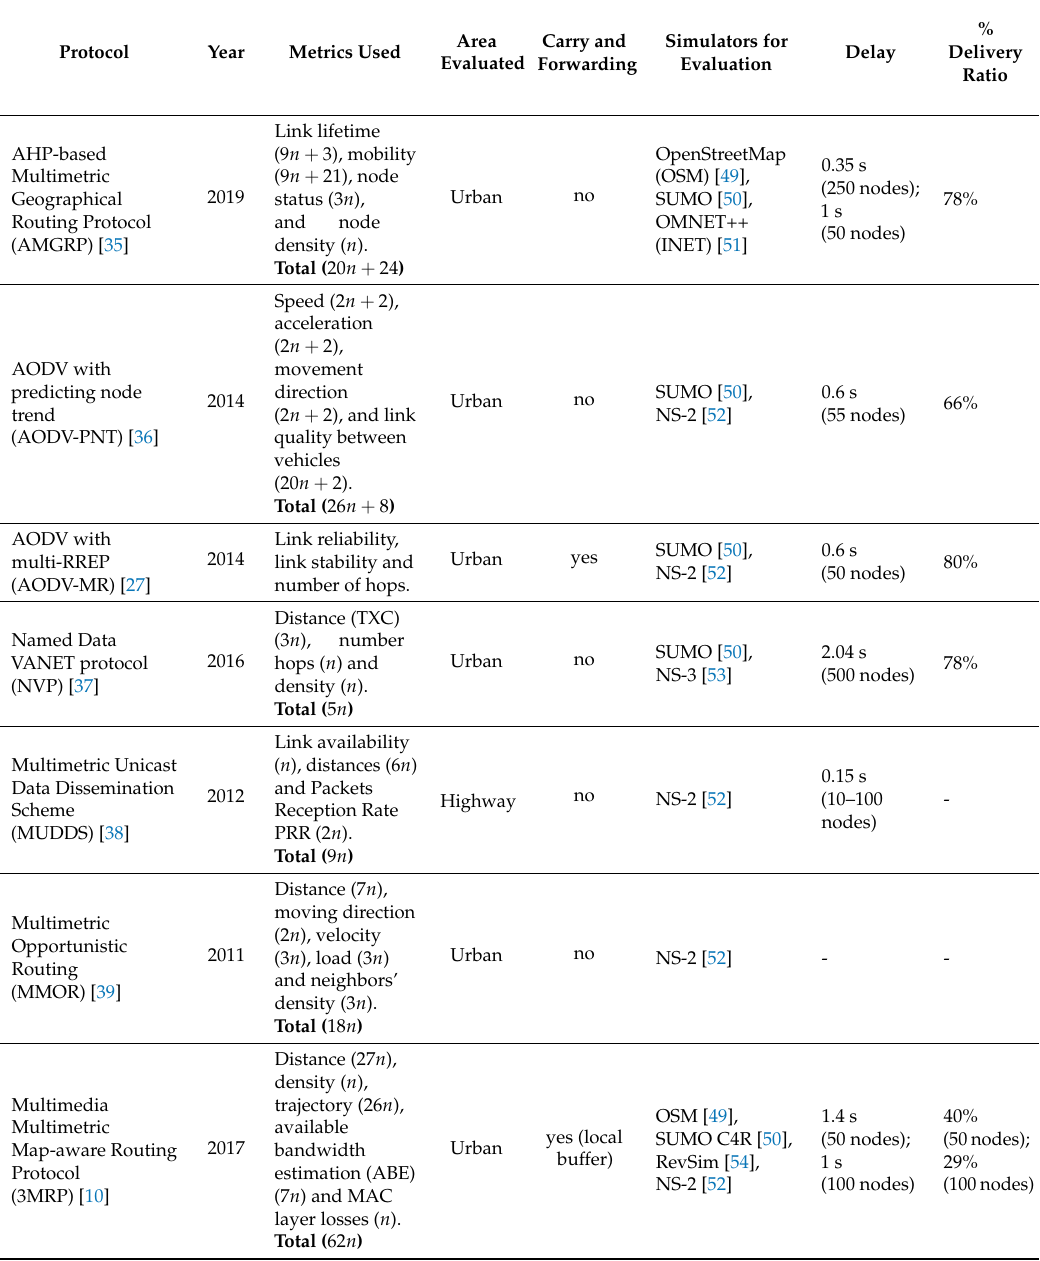
Table 5. Multimetric routing protocols in a vehicular ad hoc network (VANET). Number of operations shown with each metric was approximated and based on number of neighbors n , which does not consider any other phase, such as protocol initialization or generation